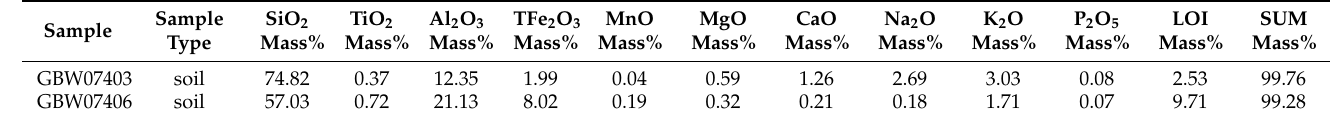
Table 2. The major element data of the reference materials analyzed in this study.